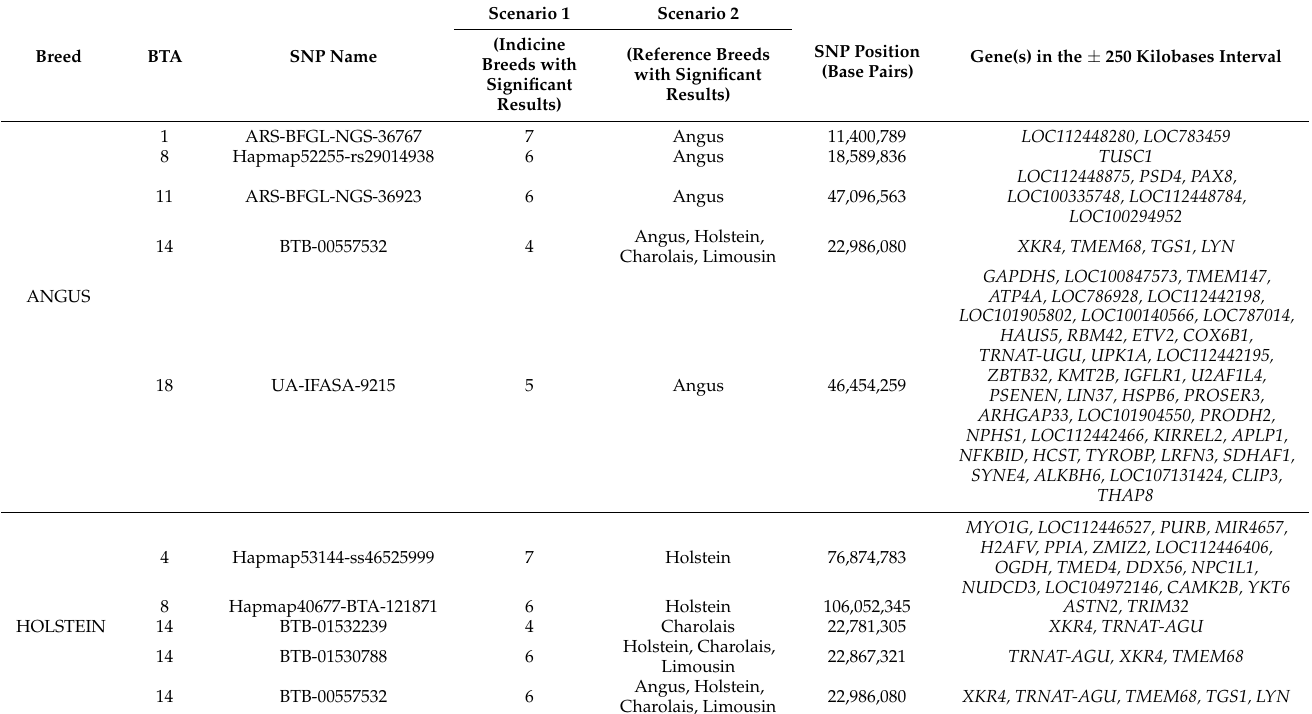
Table 3. List of outlier SNPs shared between taurine breeds [17] and indicine breeds [this